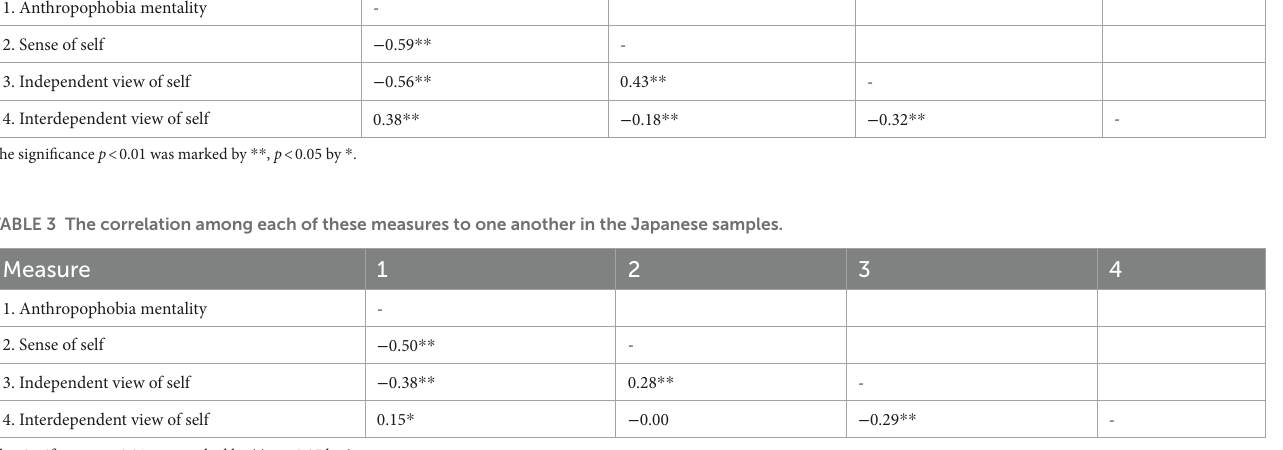
TABLE 2 The correlation among each of these measures to one another in the American samples. Measure